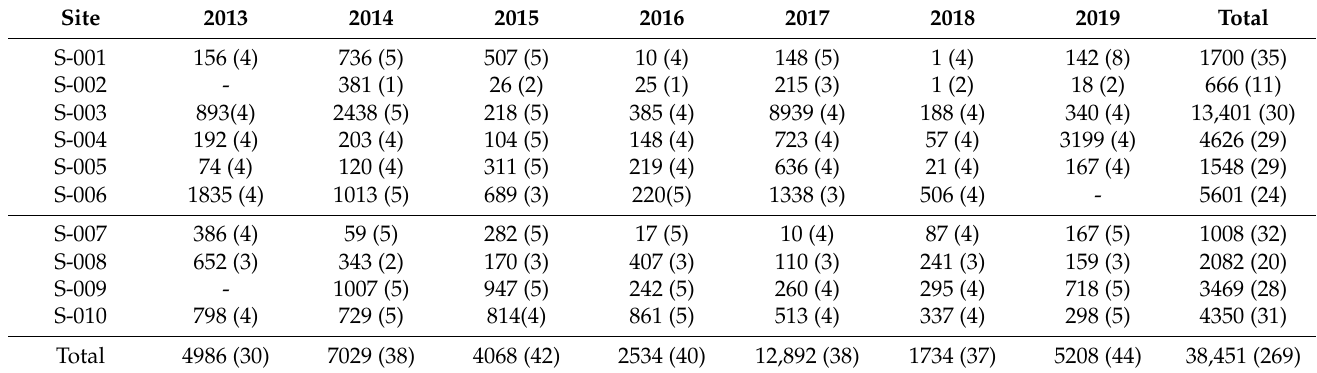
Table 1. Number of individual fish collected and the number of seine hauls conducted at shoreline seine survey sites (parentheses) in the St. Clair (S-001–006) and Detroit rivers (S-007–010) from 2013 to 2019. Sites are arranged from upstream to downstream (top to bottom). “-” indicates no samples were collected for a given site and